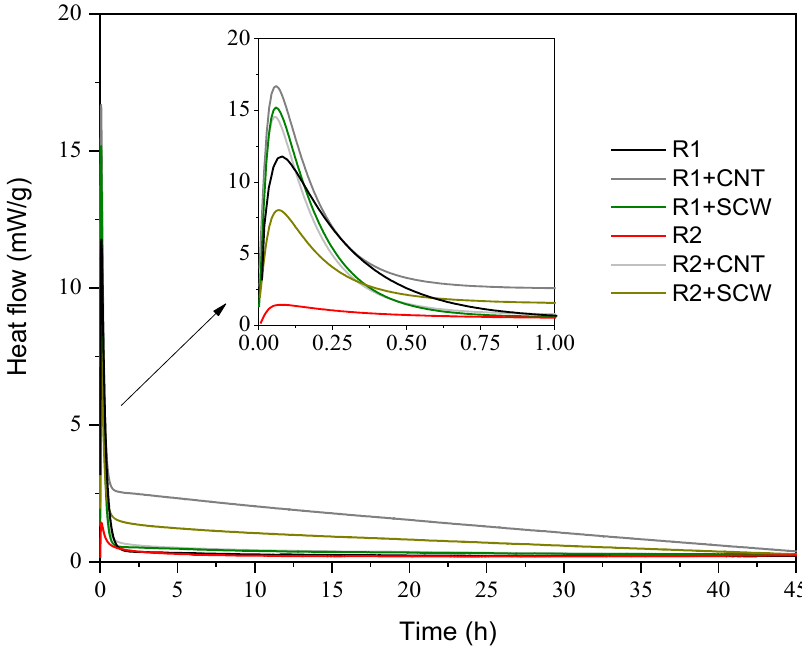
Figure 10. Heat flow and of geopolymers for 45 h.